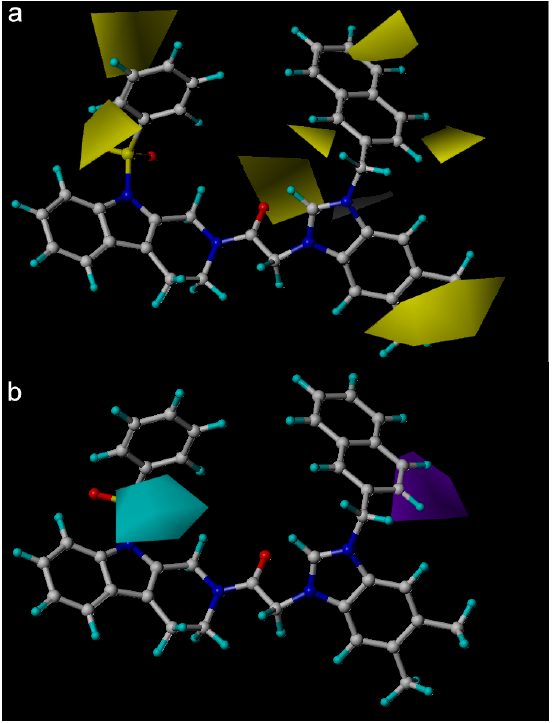
Figure 5. Hydrophobic ( a ) and H-bond acceptor ( b ) field contour maps for CoMSIA. Yellow contours represent regions where hydrophobic substituents are favorable, white contours represent regions where hydrophilic substituents are unfavorable, cyan contours indicate regions where hydrogen bond acceptor substituents increase activity, and purple contours indicate the unfavorable regions for hydrogen bond acceptor groups.